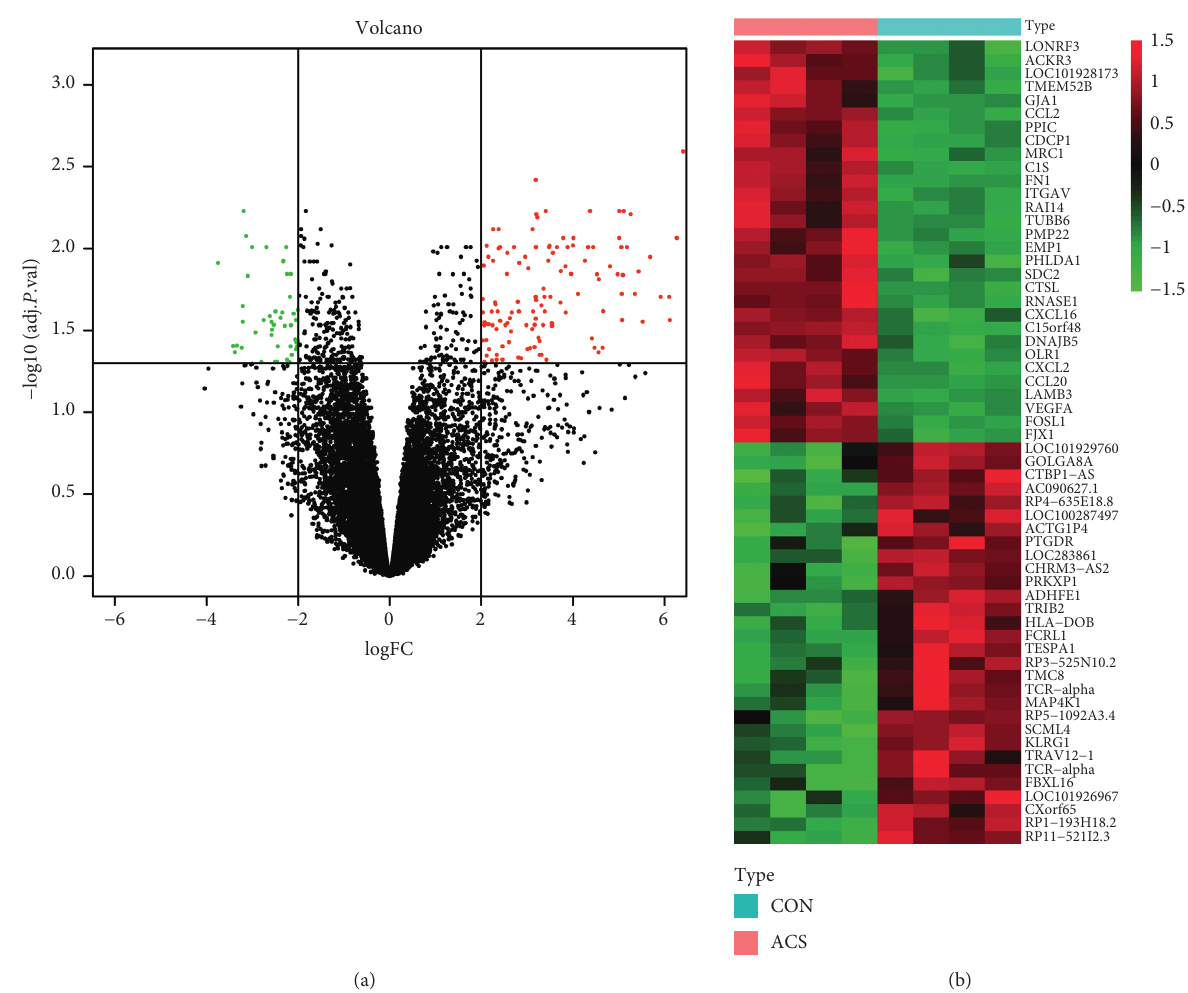
Figure 1: (a) The volcano plot was presented, in which green dots represented downregulated genes and red dots represented upregulated genes in ACS samples. (b) Heat map of gene expression. Each row represented one DEG, and the color gradually changed from green to red, indicating the shift of gene expression from low to high. ACS: acute coronary syndrome; DEG: differentially expressed